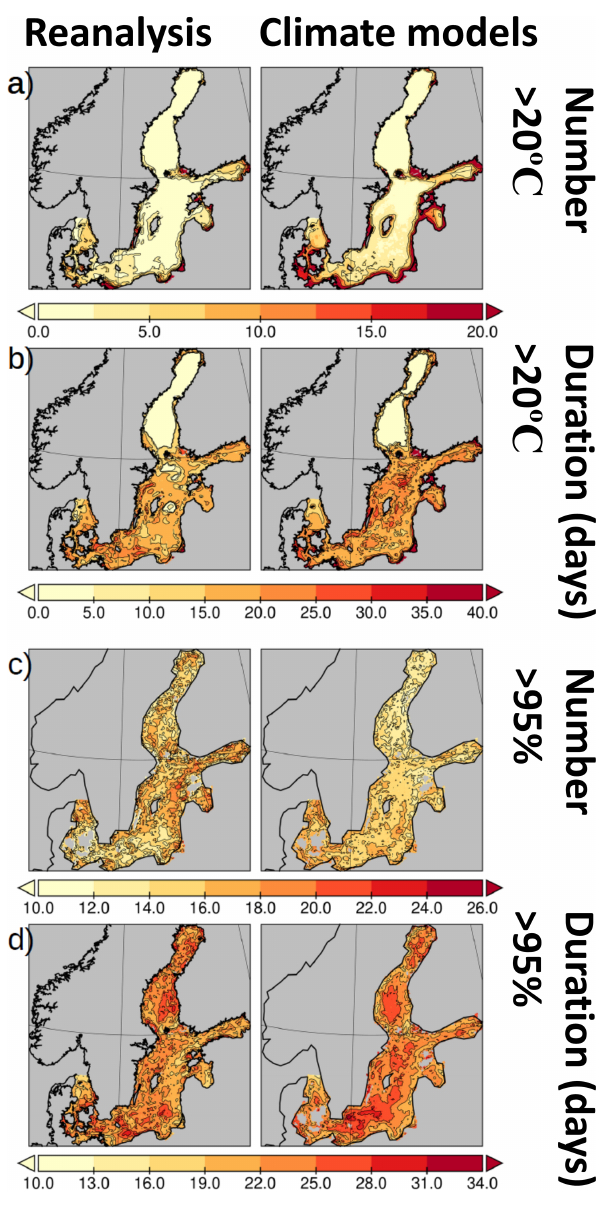
Figure 6. (a) Number of > 10d periods in which the SST exceeds 20 ◦ C. (b) Average duration of the periods displayed in panel (a) . (c) Number of 10d periods in which the SST exceeds the 95th per- centile. (d) Average duration of the periods displayed in panel (c) . Left column: reanalysis data (Liu et al., 2017). Right column: en- semble mean of the scenario simulations driven by four ESMs (Saraiva et al., 2019a). The analysis period is 1976–1999. Note the different colour scales used in panels (c) and (d)